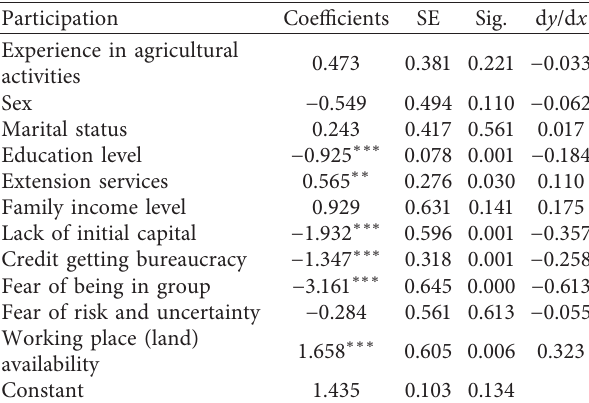
Table 3: Determinants of youth participation in agricultural